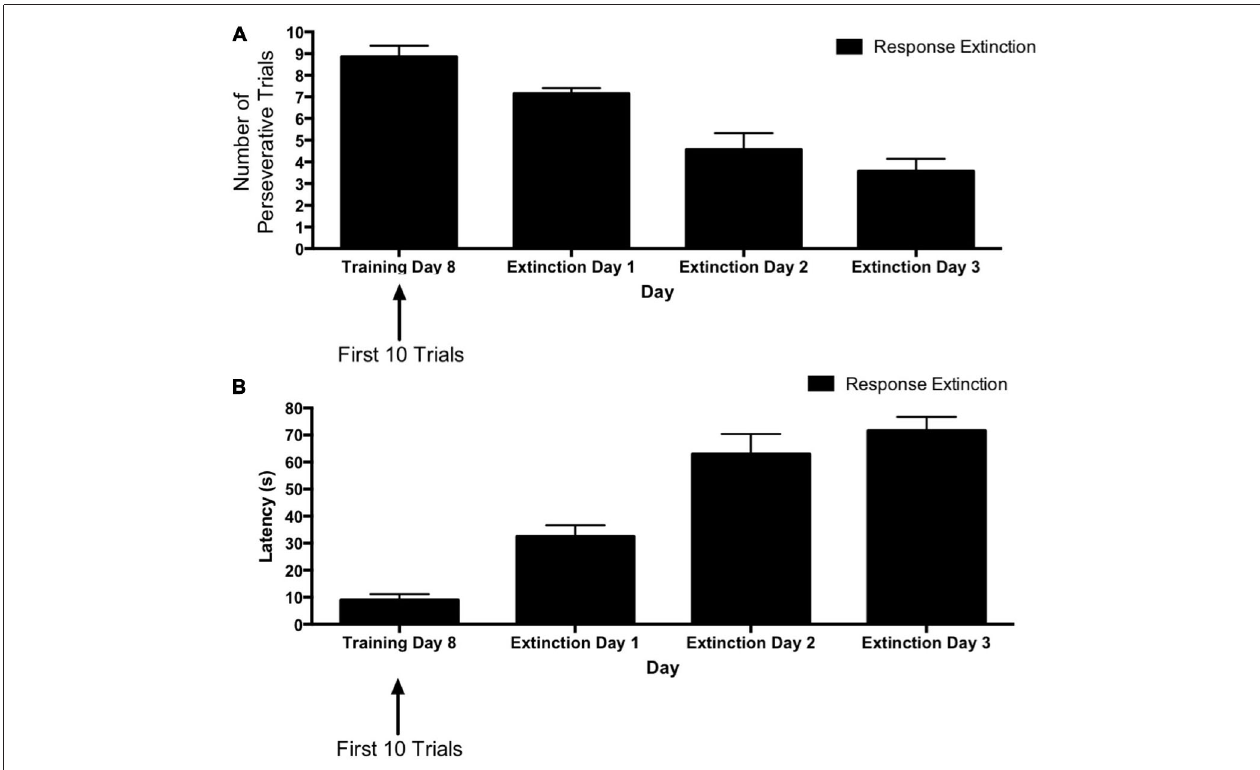
FIGURE 2 | Response extinction of hippocampus-dependent place learning. (A,B) For animals in the response extinction group, the number of perseverative trials decreased (A) and latency increased (B) over the course of extinction training, indicating the effectiveness of response extinction.